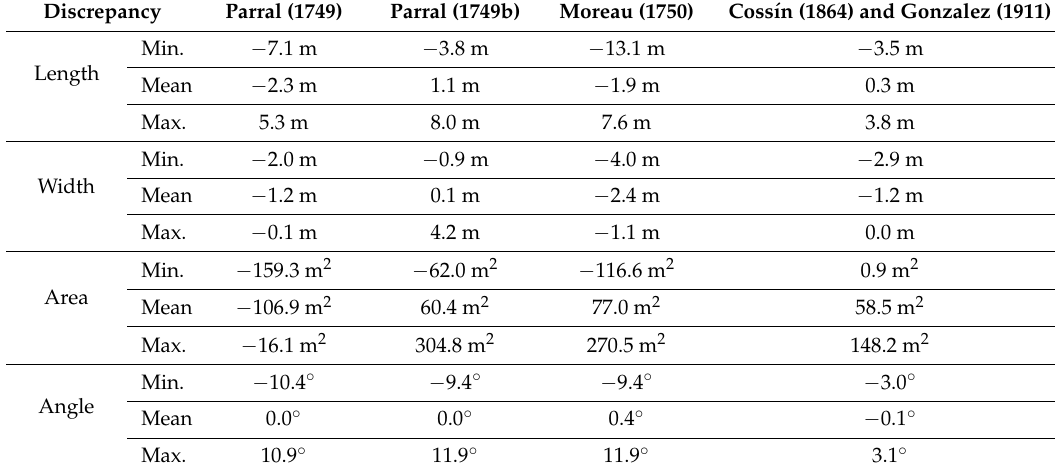
Table 3. Summary of geometrical invariant discrepancies for the Alc á zar 4D modeling.